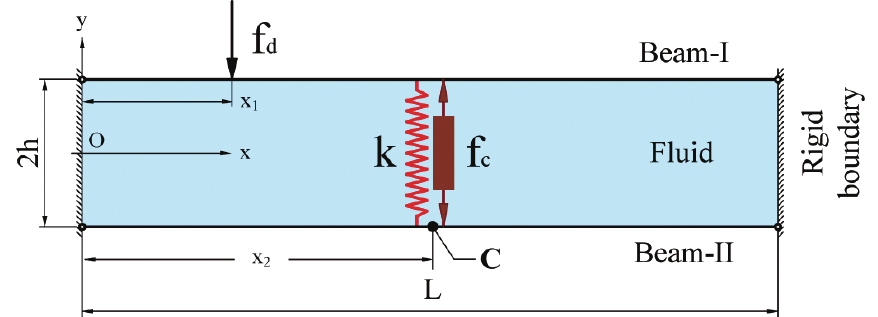
Fig. 1. Physical model of the double-beam